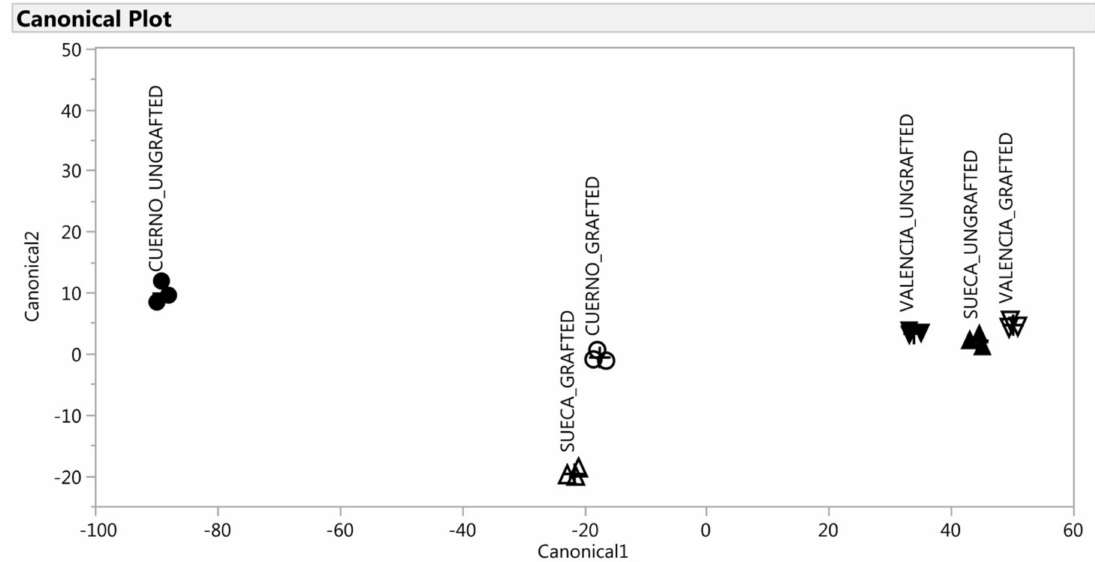
Figure 6. Discrimination of the VOCs of the red fruit on the basis of the canonical